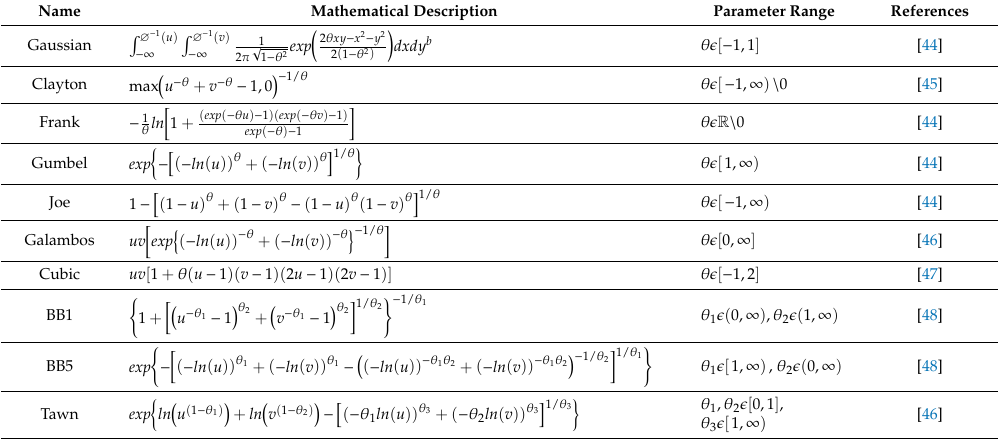
Table 1. Summary of selected copula families adopted from [43]. The BB1 copula is derived from the combination of extreme cases of the Clayton and Gumbel copulas while BB5 is a 2-parameter extension of the Gumbel